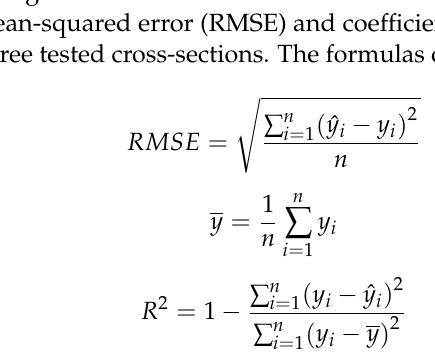
Figure 3. Comparisons of the mean streamwise velocity profiles of the test lines between the simula- tion results and experimental data.